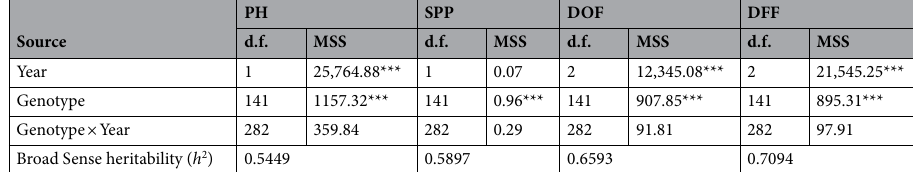
Table 2. Pooled Analysis of Variance (Pooled-ANOVA) for four traits evaluated in different environments.